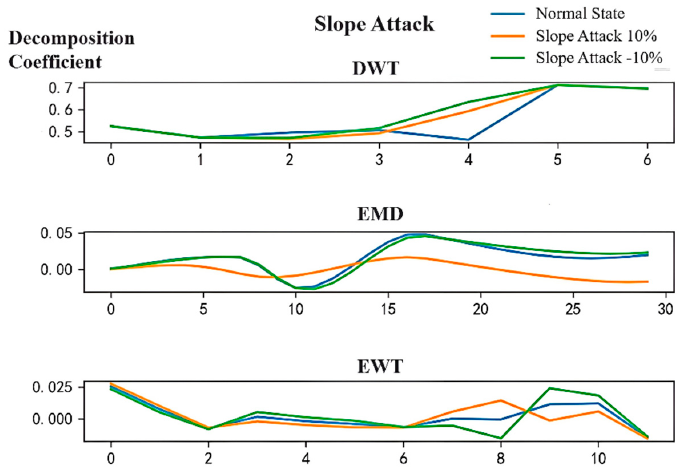
Figure 5. Decomposition coefficients of time-frequency transform under a slope attack.